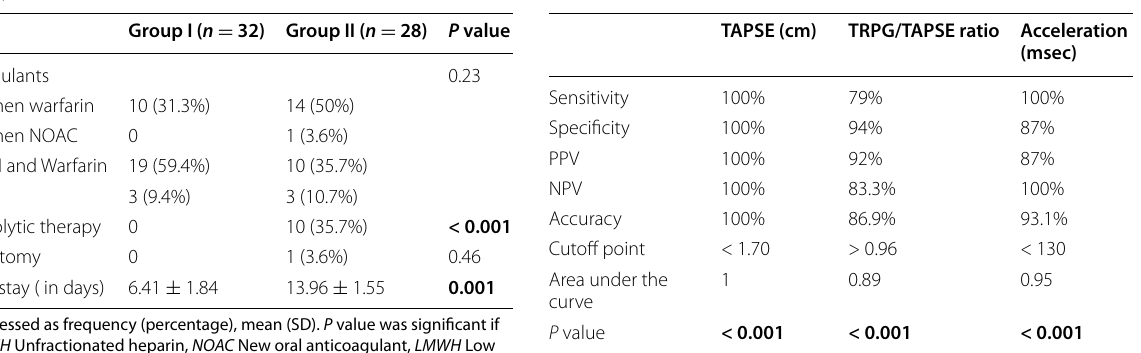
Table 4 Lines of management and duration of hospital stay in studied patients